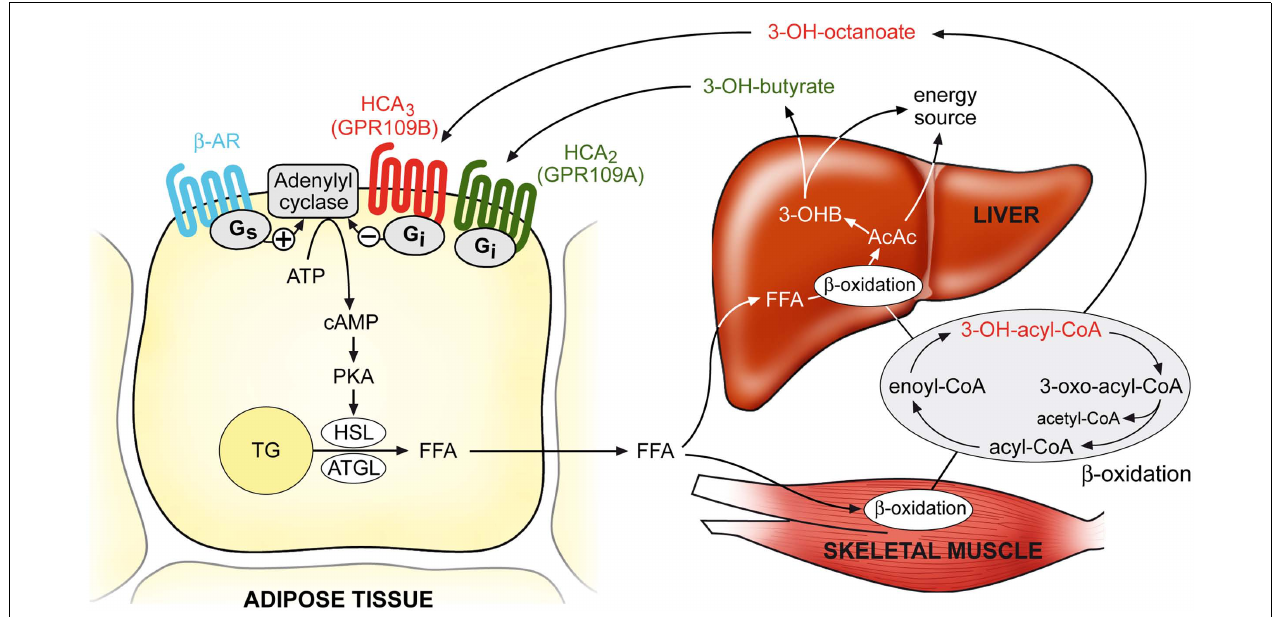
FIGURE 3 | Model of the physiological functions of HCA 2 and HCA 3 receptors. During conditions of increased β -oxidation rates (e.g., during fasting), plasma concentrations of the ketone body 3-hydroxybutyrate and β -oxidation intermediates, in particular 3-hydroxy-octanoate, reach levels sufficient to activate their respective receptors HCA 2 and HCA 3 , which then mediate an inhibition of adipocyte lipolysis through G i /G o -dependent inhibition